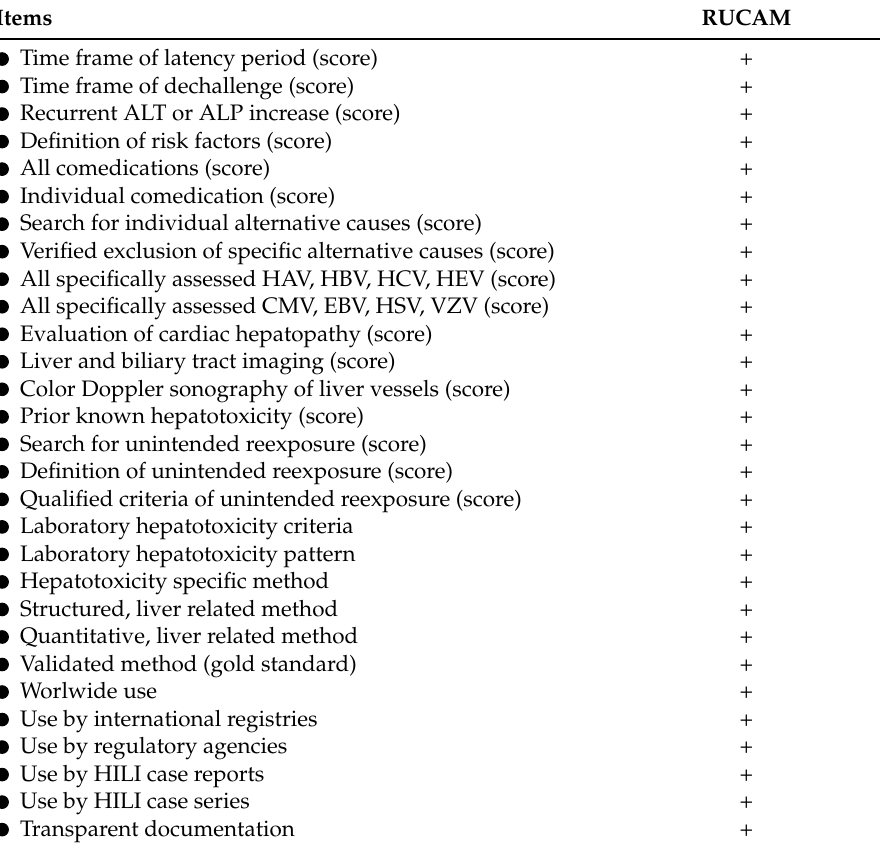
Table 7. Core elements and advantages of